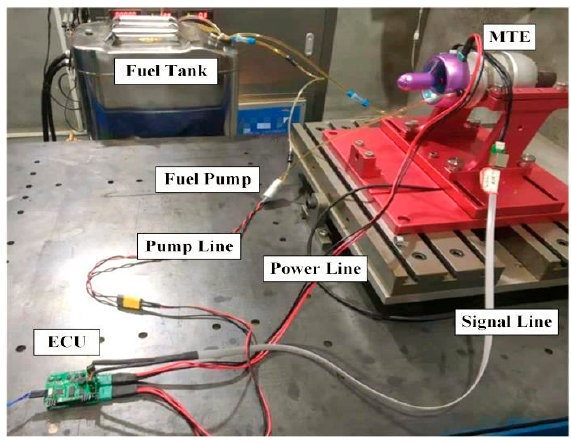
Figure 11. Experimental setup.